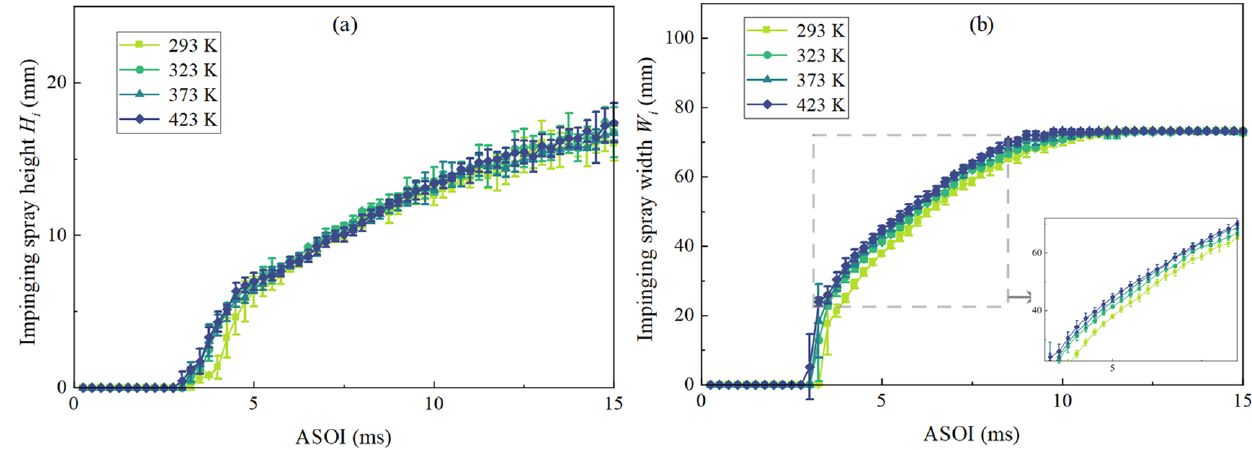
H and ( b ) width Figure 9. ( a ) Impinging spray height Figure 9. ( a ) Impinging spray height H i and ( b ) width W i of impinging spray under different T wall . i . Figure 10 showed the impinging spray morphology under different injection pressure P inj (from 300 kPa to 500 kPa). At the same time, after the start of injection, the speed of methanol spray was positively correlated with P inj .